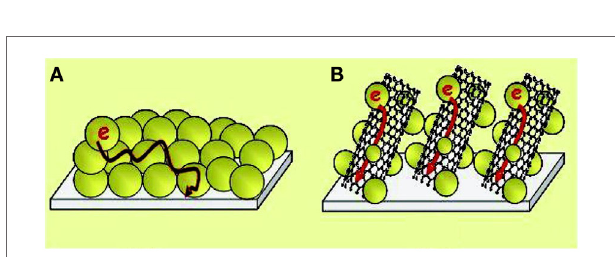
FiGURe 11 | electron transport through pure TiO 2 nanoparticles (A) versus across CNTs (B) . (Kongkanand et al., 2007) Copyright ACS Publications,